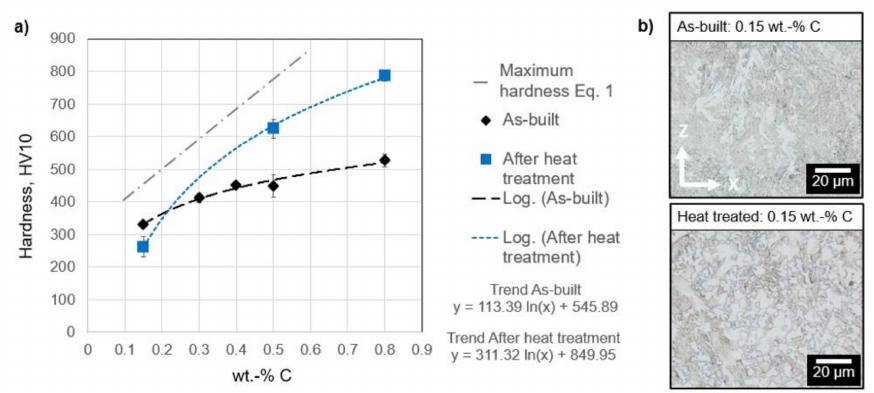
Figure 8. ( a ) Hardness measurements in the as-built and heat-treated state. Hardness after PBF-LB/M is higher before a heat treatment for low carbon content ( b ) Microstructure of 16MnCr5 with 0.15 wt.% C before and after heat